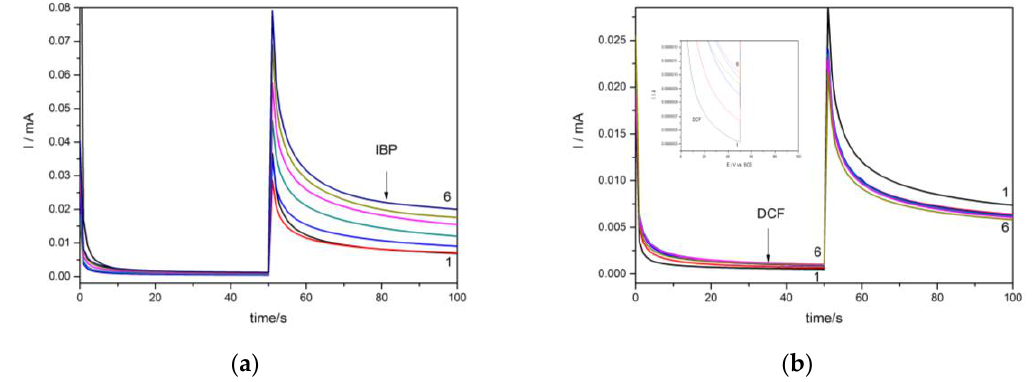
Figure 4. CA recorded under two potential levels of +0.8 V and +1.25 V vs. SCE at the HKUST-CNF electrode in 0.1 M Na 2 SO 4 supporting electrolyte (curve 1) and in the presence of ( a ) 2 mg·L −1 IBP (curve 2), 4 mg·L −1 IBP (curve 3), 6 mg·L −1 IBP (curve 4), 8 mg·L −1 IBP (curve 5), 10 mg·L −1 IBP (curve 6); ( b ) 2 mg·L −1 DCF (curve 2), 4 mg·L −1 DCF (curve 3), 6 mg·L −1 DCF (curve 4), 8 mg·L −1 DCF (curve 5), 10 mg·L −1 DCF (curve 6).